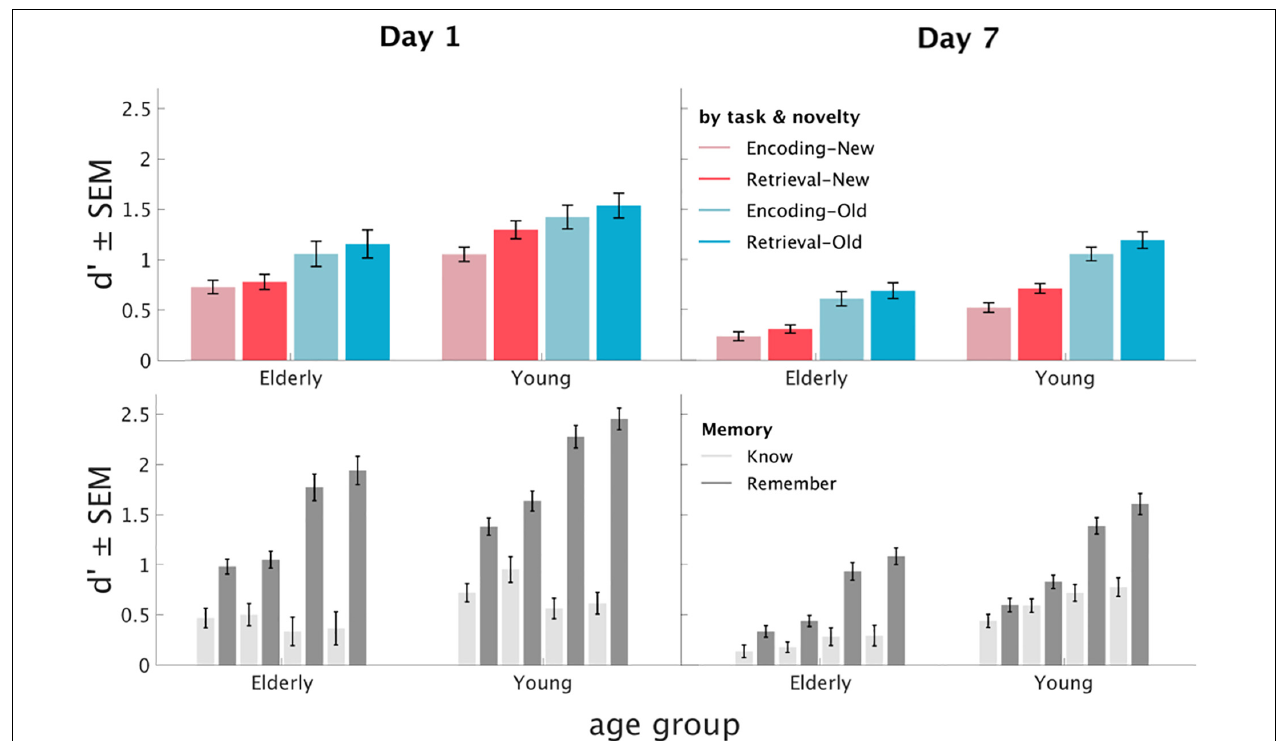
FIGURE 2 | Memory performance for Day 1 and Day 7. D (cid:48) values for all conditions: Day (separate plots), Age group ( x -axis), Memory (lightness), Task (color saturation), stimulus Novelty (color temperature, blue = old).